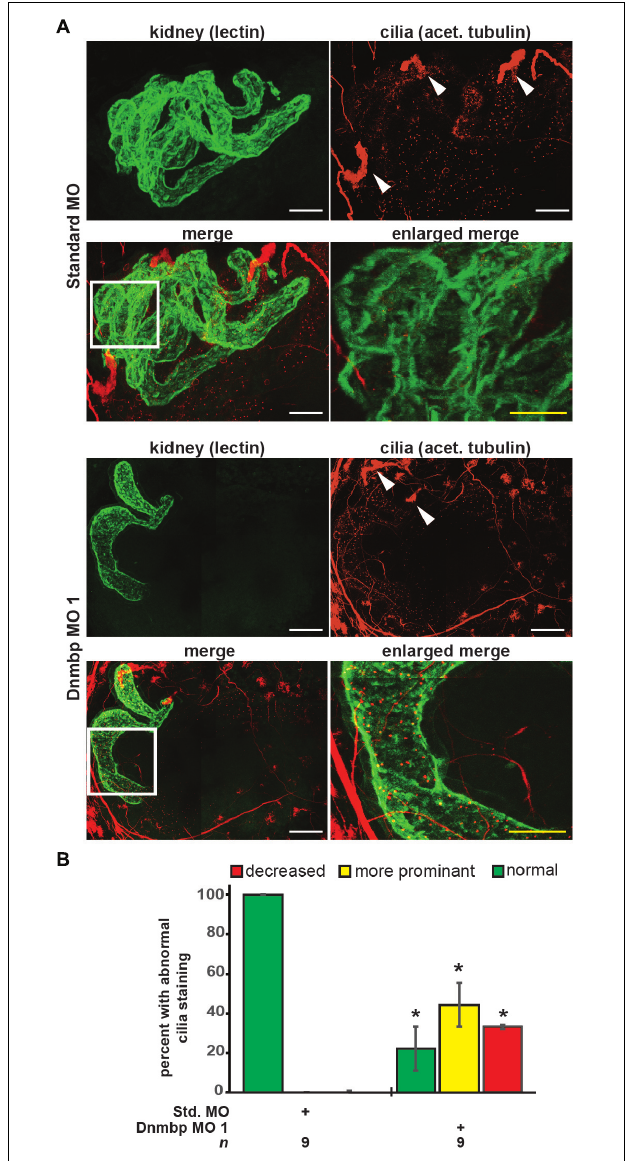
FIGURE 4 | Dnmbp knockdown alters ciliogenesis. (A) Unilateral injection of 20ng Dnmbp MO 1 into blastomere V2 at the 8-cell stage causes altered primary ciliogenesis in comparison to embryos injected with Standard MO. Longer primary cilia are visible in the proximal tubules of the Dnmbp knockdown embryos (“more prominent cilia” phenotype). Acetylated tubulin antibody used to label cilia and nerves and lectin used to label the proximal tubule lumen. Images are stitched from 6 tiles. White bar is 50 µ m, yellow bar is 25 µ m. White arrowhead indicates nephrostome. White box indicates region represented in the enlarged merge panel. (B) Knockdown of Dnmbp leads to altered primary cilia development compared to embryos injected with Standard MO. n = number of embryos across 3 replications. Error bars represent Standard error. ∗ Significantly different from control, p < 0.05.